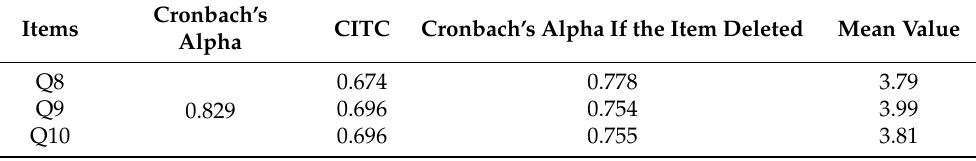
Table 6. The reliability analysis of the learning effects within the